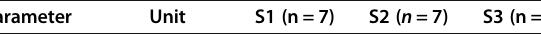
Table 1 Moisture content analysis of the aged waste recovered from landfill Parameter